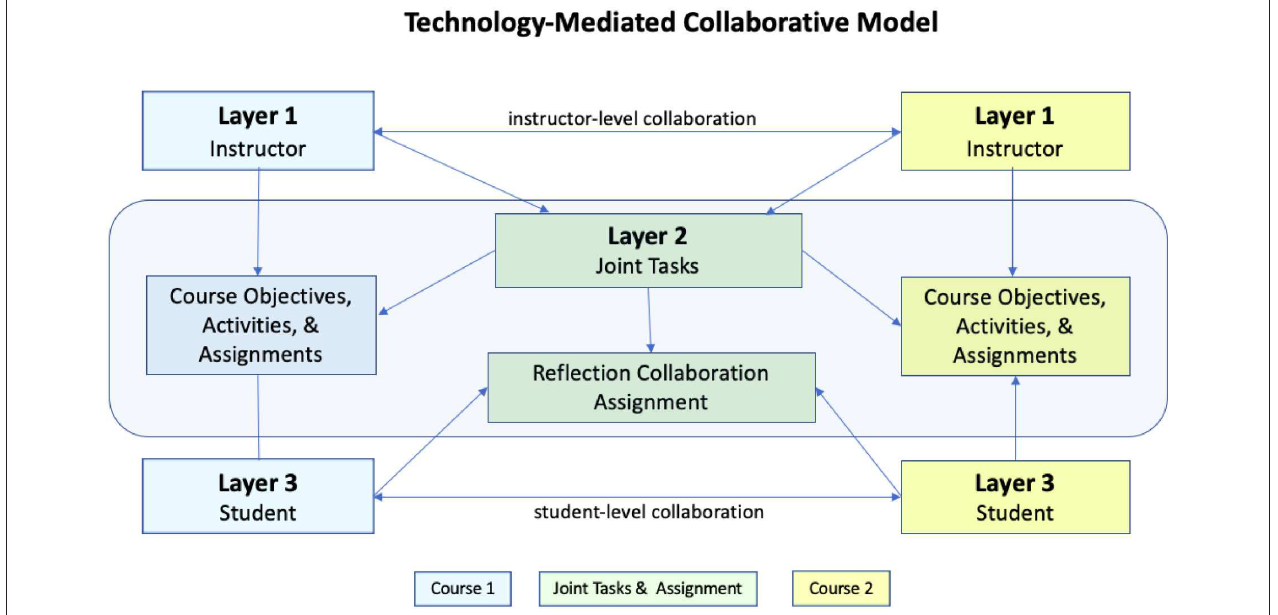
FIGURE 1 | Technology-mediated collaboration